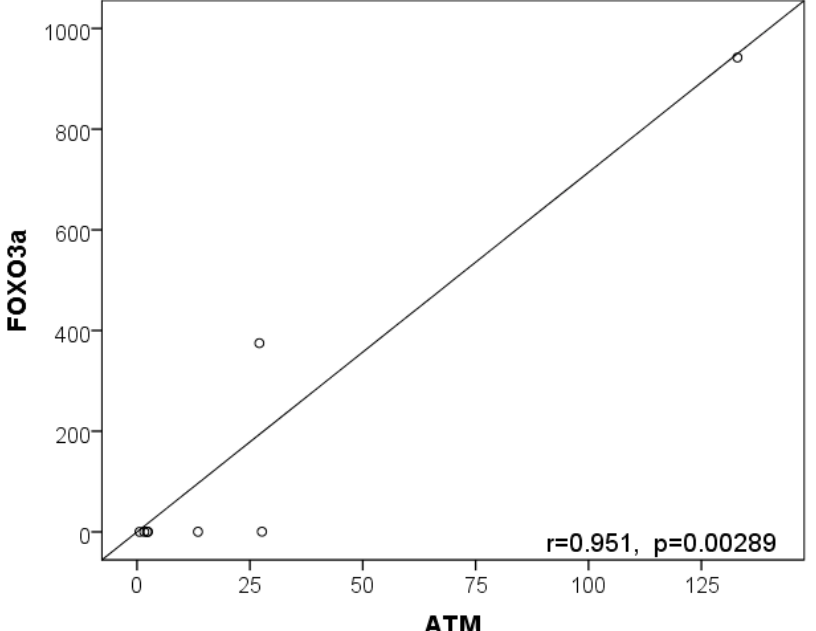
Figure 4. Correlation between FOXO3a and ATM expression in BCC patients’ biopsies. Pearson correlation of FOXO3a and ATM gene expression fold changes among BCC patients revealed a strong positive correlation of these genes with a Pearson correlation coefficient (r) = 0.951 ( p = 0.00289). Each circle represents the expression levels of both genes for each patient.